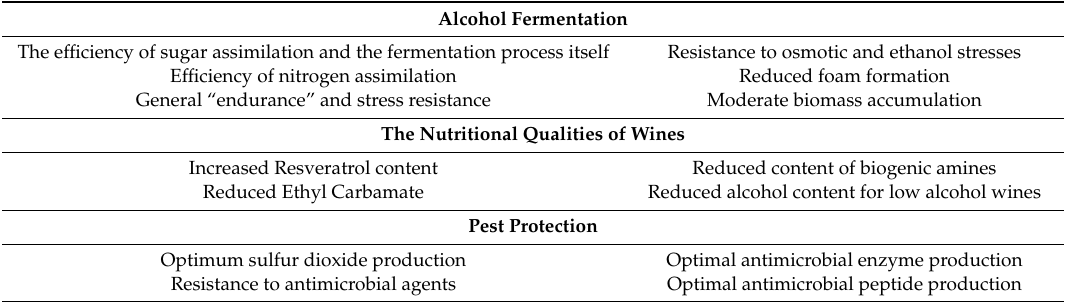
Table 1. Oenological characteristics of wine strains of S. cerevisiae -targets for metabolic